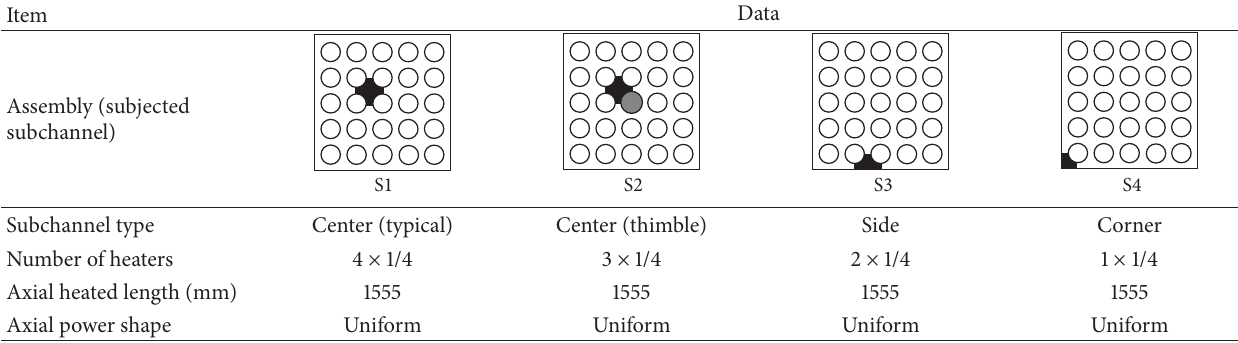
Table 6: Assembly data for assemblies S1, S2, S3, and S4.